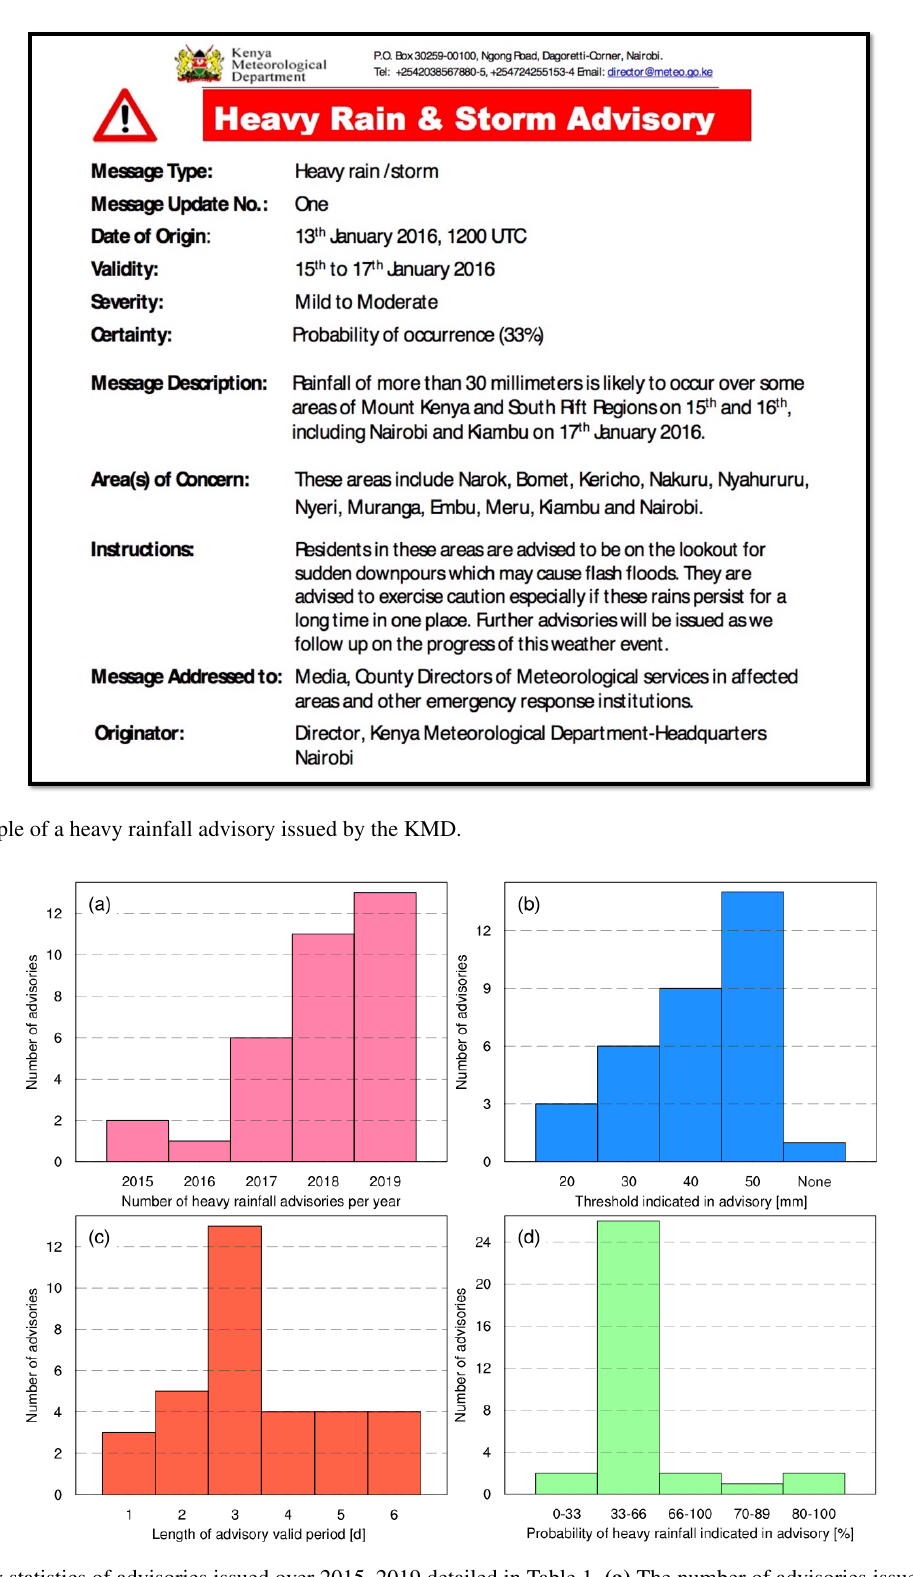
Figure 2. Summary statistics of advisories issued over 2015–2019 detailed in Table 1. (a) The number of advisories issued per year, (b) the rainfall threshold mentioned, (c) the length of the valid period, and (d) the probability